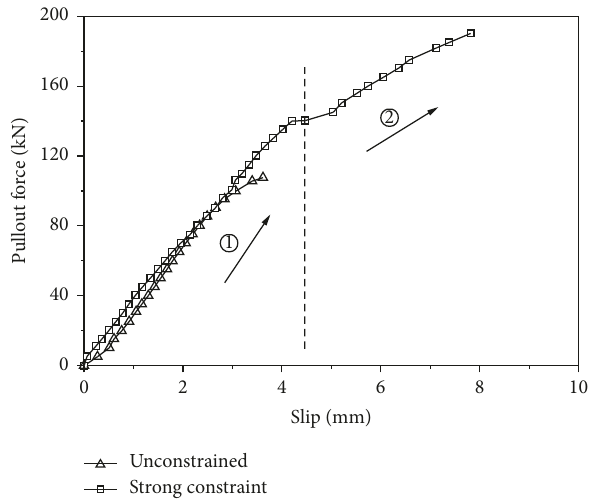
Figure 13: Single load-slip curves corresponding to two types of constraint conditions.